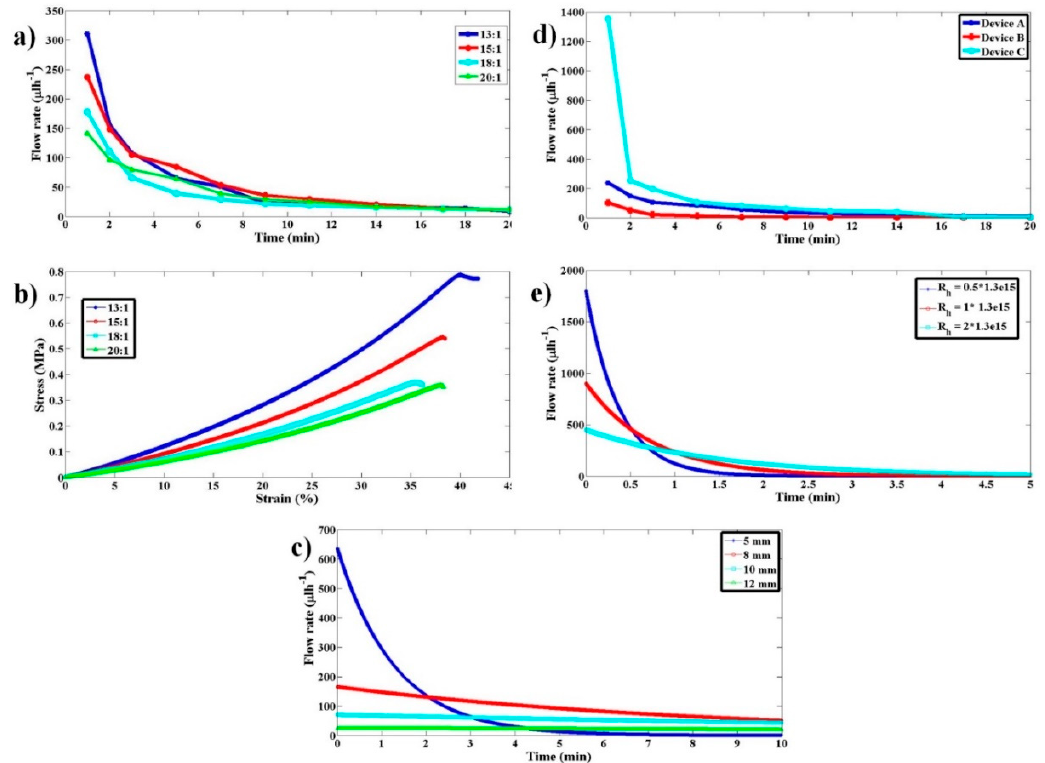
Figure 7. Flow rate variation characterization with respect to variations in PDMS stiffness, sample syringe inner diameter, and hydrodynamic resistance of the microfluidic device connected. ( a ) Experimental flow rate as a function of time for the proposed pump when PDMS blocks with 13:1, 15:1, 18:1, and 20:1 ratios were used. ( b ) The stress–strain curves for the respective PDMS blocks in (a). ( c ) Simulation results illustrating the dependence of flow rate on sample syringe inner diameter for 5, 8, 10, and 12 mm. ( d ) Experimental flow rate as a function of time for the proposed pump when a PDMS block with 15:1 ratio and di ff erent hydrodynamic resistance (Devices A, B, and C) were used. ( e ) Simulation results illustrating the flow rate dependence on microfluidic device hydrodynamic resistance.